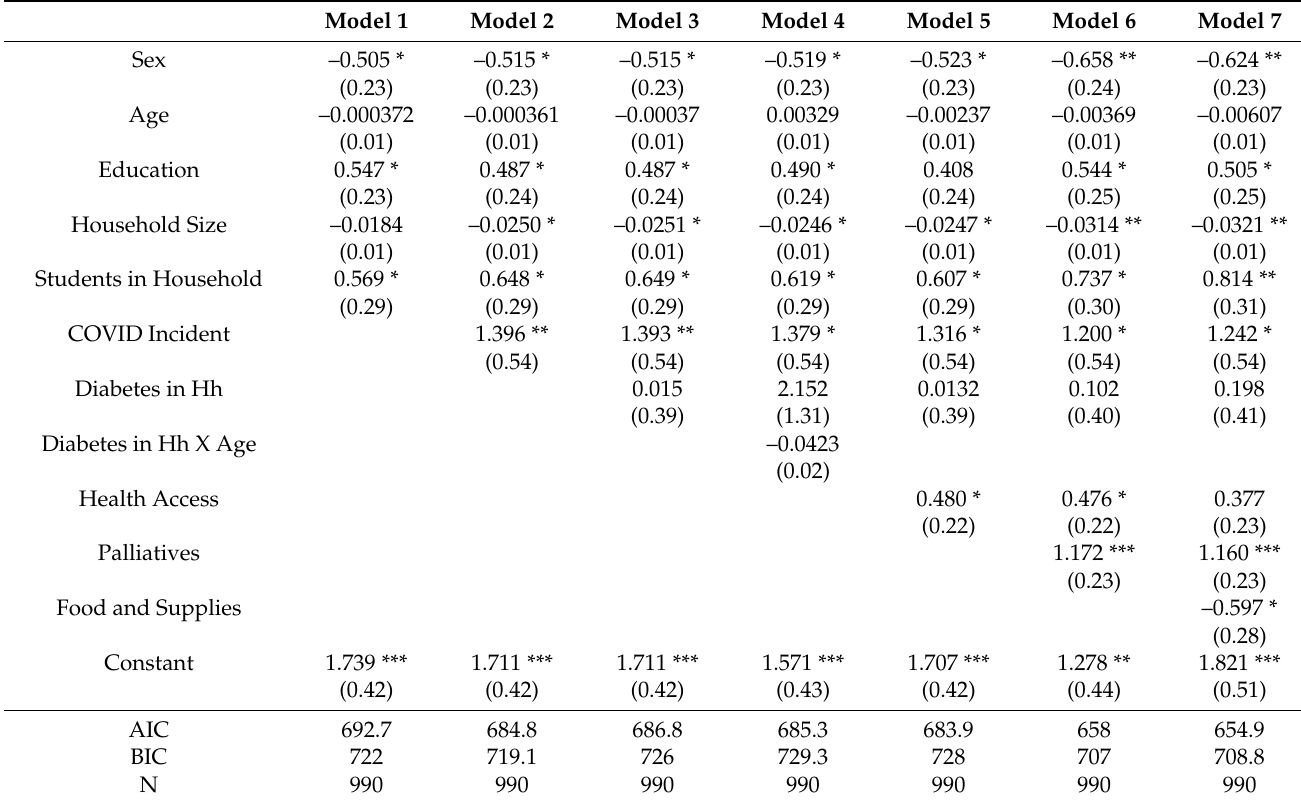
Table 2. Random effects logistic model: DV = mask wearing (1) or not wearing mask (0). Note— Hh: